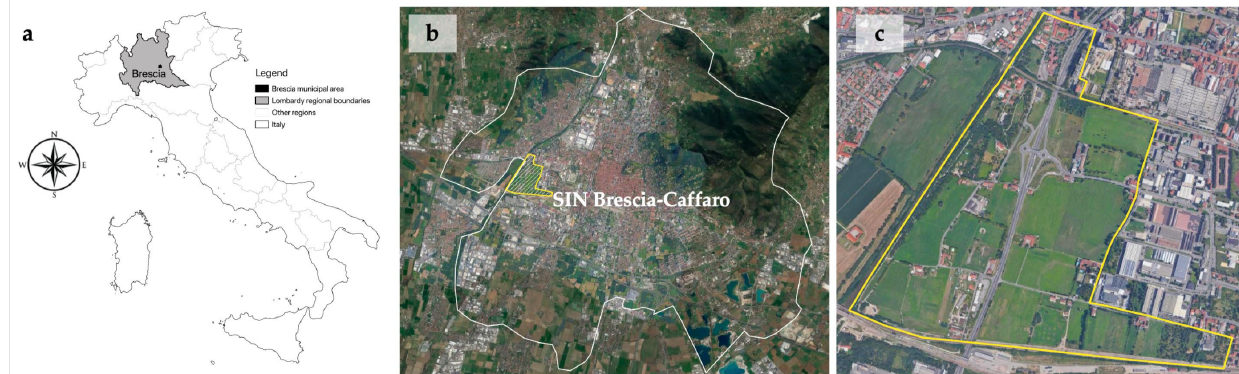
Figure 1. Case study area: ( a ) Brescia municipality within the national context; ( b ) SIN Brescia-Caffaro study area within Brescia municipality; and ( c ) SIN Brescia-Caffaro study area in